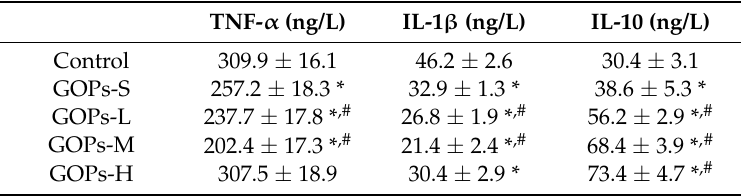
Table 1. Effect of GOPs on inflammatory parameters in serum of granuloma rats.